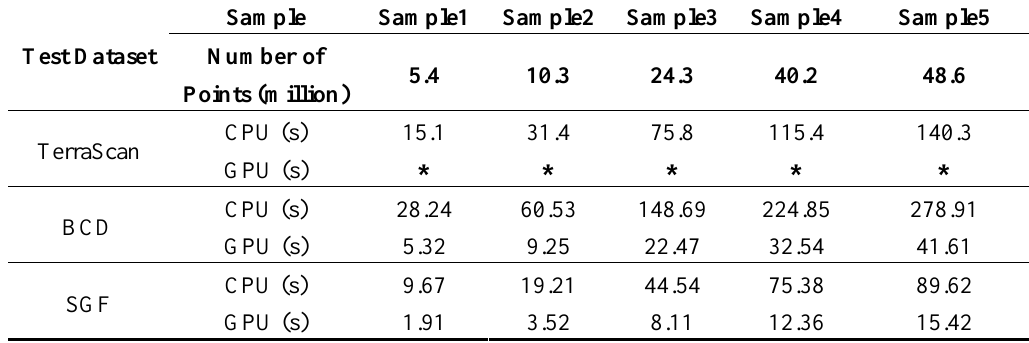
Table 2. Comparison of computational performance between TerraScan, BCD, and